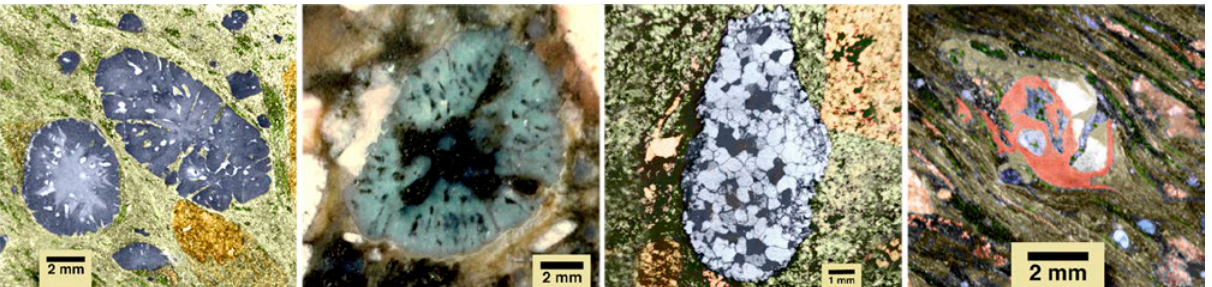
Figure 6. Quartz “phenocrysts” from the Tennant Creek porphyroids are typically rounded, embayed with crack patterns interpreted as due to syneresis shrinkage. Some show soft or fluidal contacts with feldspar, many are mosaics of smaller interlocking crystals and there are clear examples of colloidal silica (jasper, chert) aggregation.